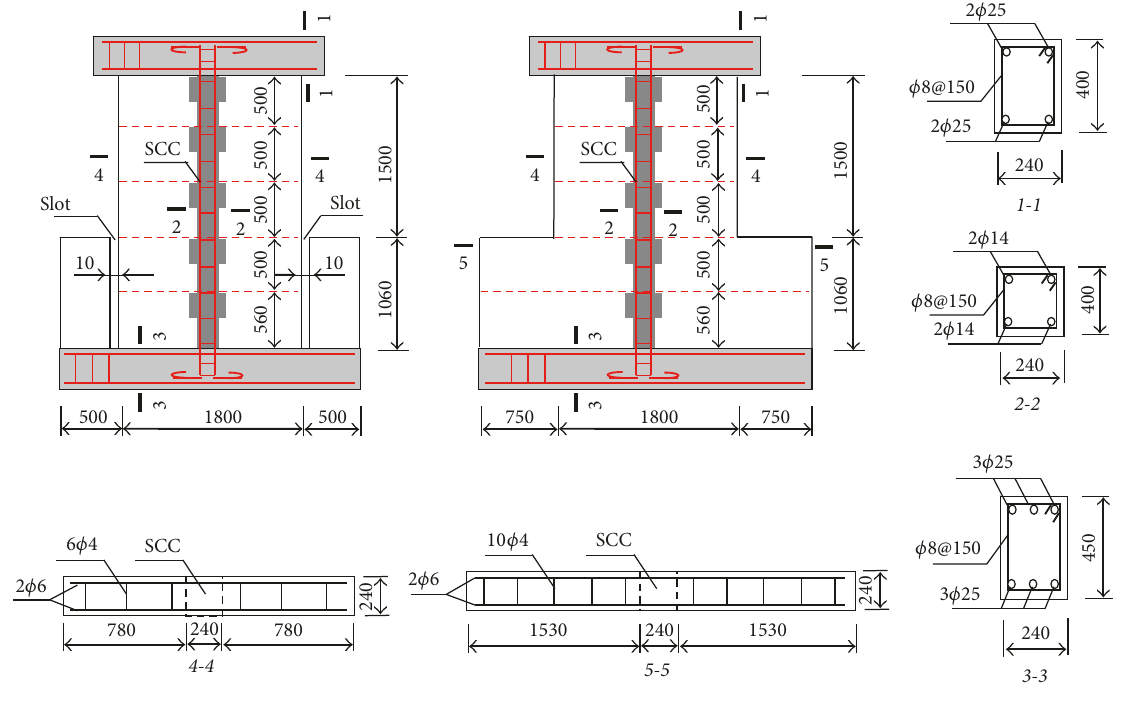
Figure 7: Details of specimens